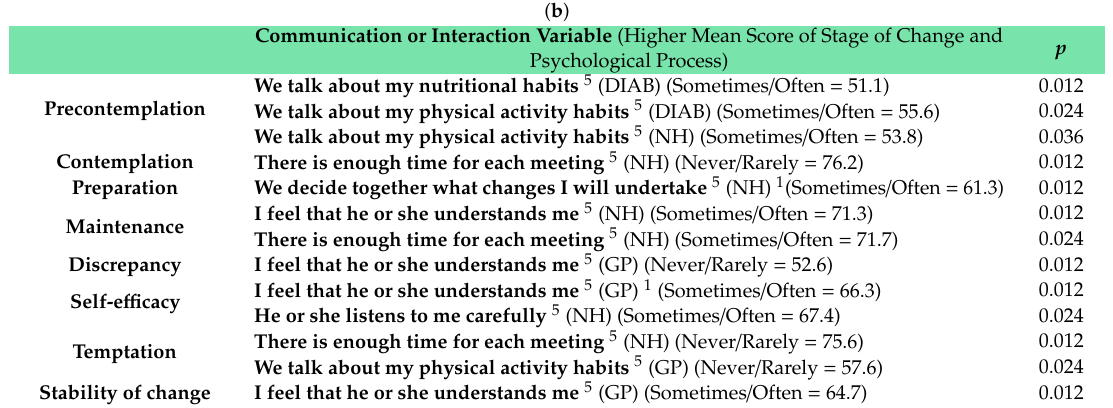
( b ) Communication or Interaction Variable (Higher Mean Score of Stage of Change and Psychological